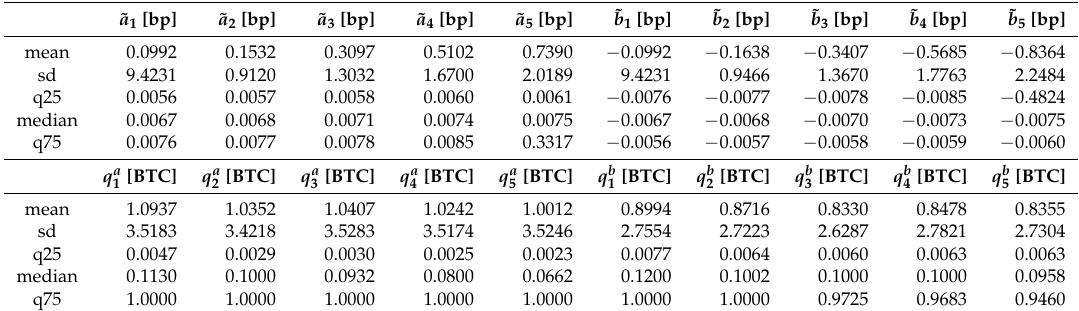
Table A1. Descriptive statistics of the average order book for the Coinbase BTC/USD market. The table reports descriptive statistics for the relative prices (˜ a i and ˜ b i ) and depths ( q a the first five limit order steps.